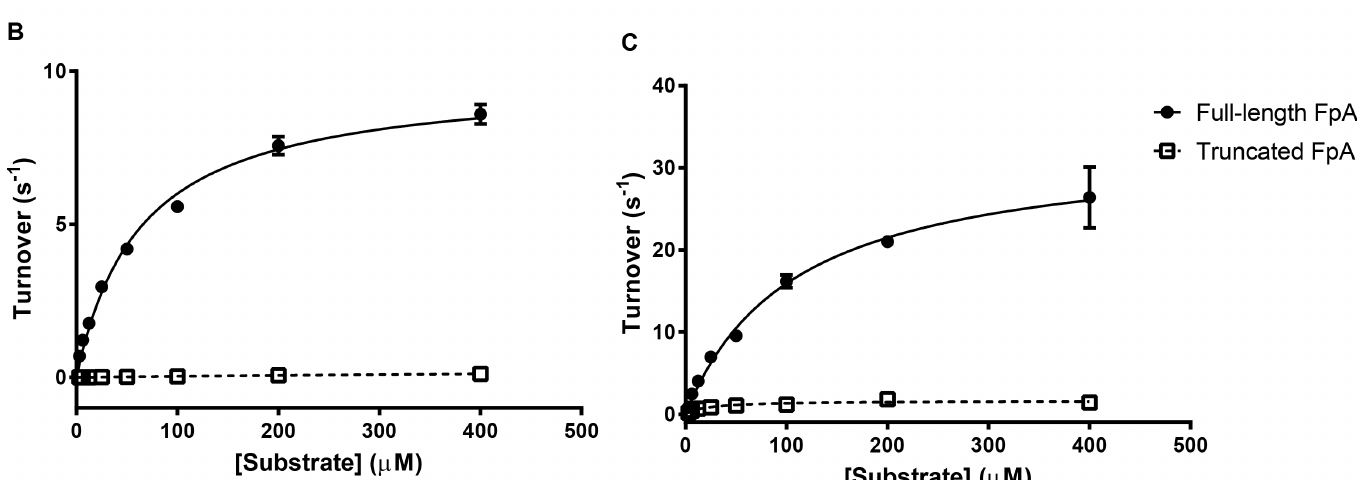
PLOS ONE | DOI:10.1371/journal.pone.0158114 July 20,